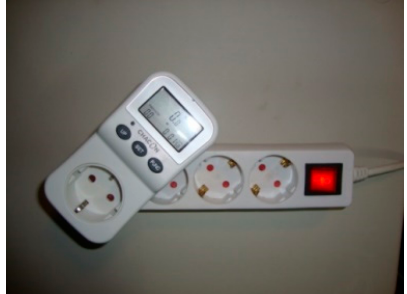
Figure 26. Wattmeter used in our experiment.